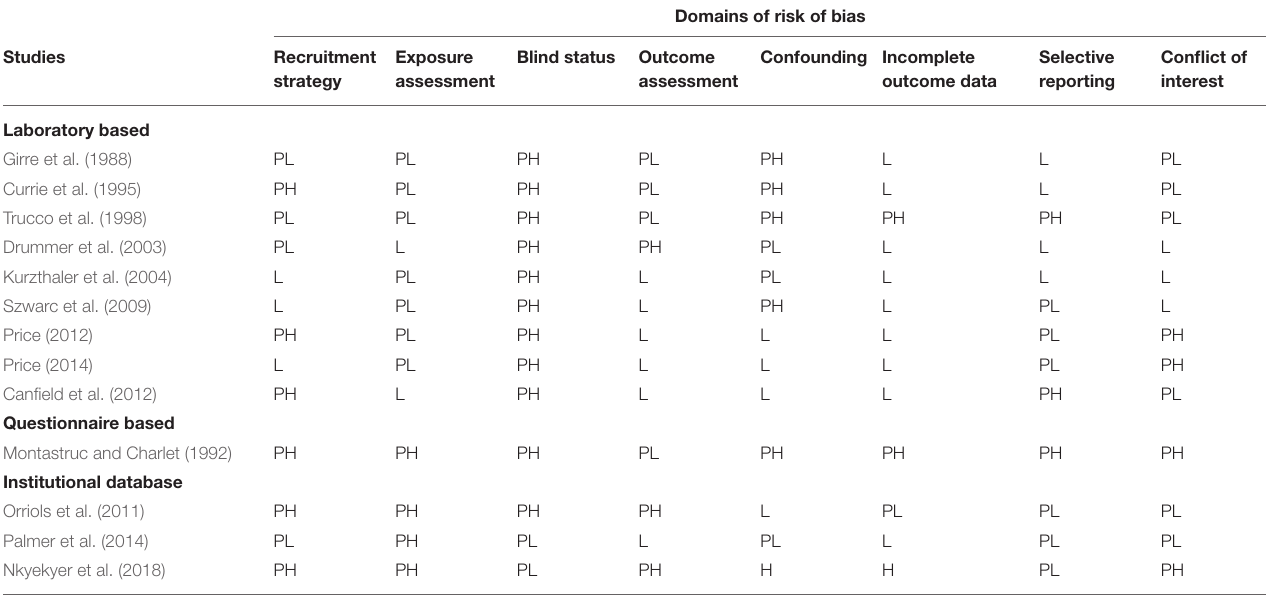
TABLE 2 | Assessment of quality of the studies included in meta-analysis: review authors’ rates about each domain of risk of bias for each included study (L, Low risk; PL, Probably low risk; PH, Probably high risk; H, High